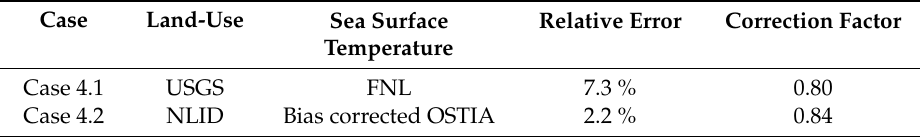
Table 6. Cases used to evaluate the predicted annual average wind speed.